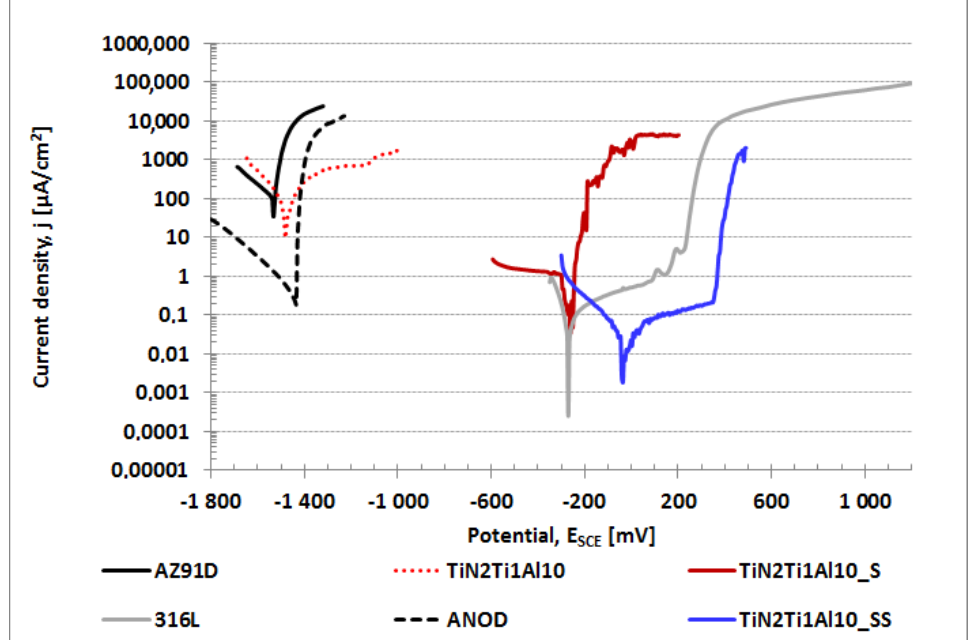
Figure 6. Polarization curves for uncoated (AZ91D) and anodized (ANOD) magnesium AZ91D alloy and for the alloy with various variants of composite TiN-Ti-Al titanium nitride layer: as-deposited (TiN2Ti1Al10) and sealed using hydrothermal treatment: in boiling water bath (TiN2Ti1Al10_S); in overheated steam (TiN2Ti1Al10_SS). For comparison, 316L stainless steel.